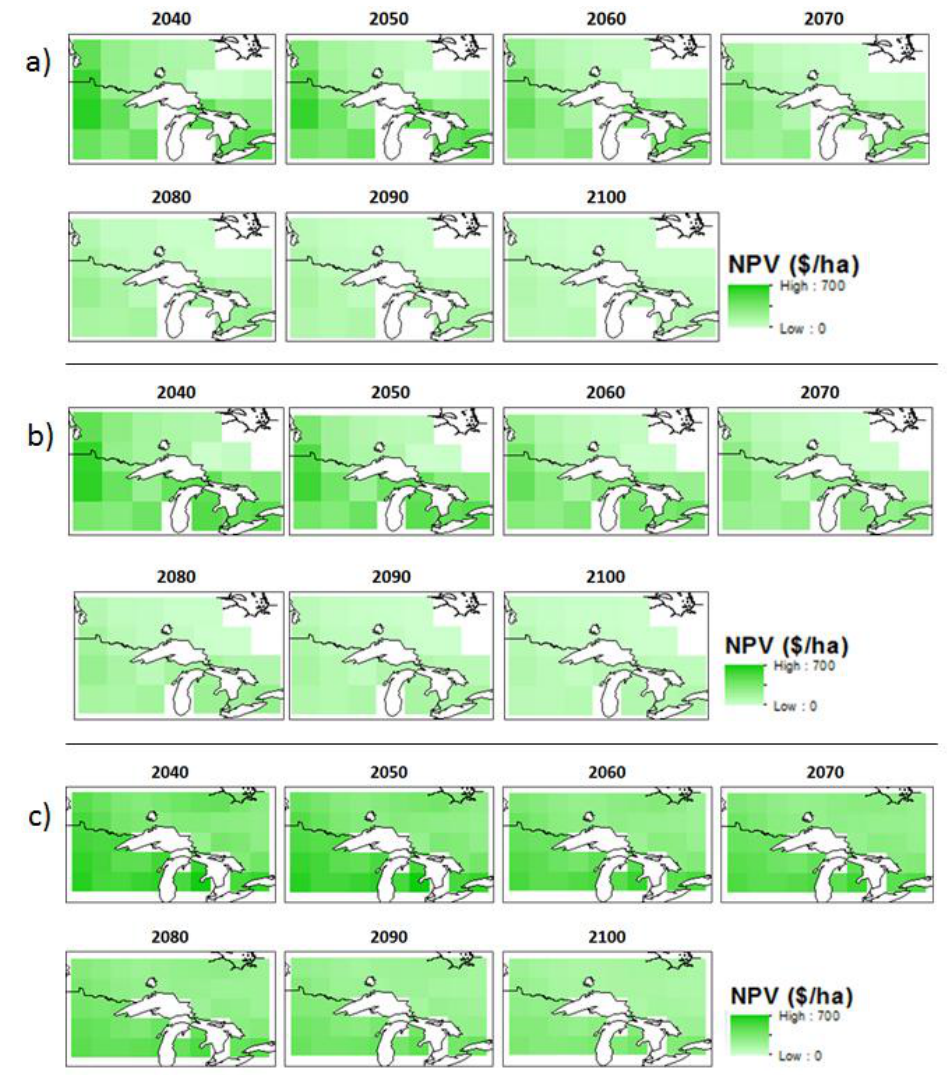
Figure 6. Spatial distribution of Net Present Values (NPVs) based on wood and carbon sequestration benefits for ( a ) CanEMS2; ( b ) MIROC; and ( c ) MPI model.